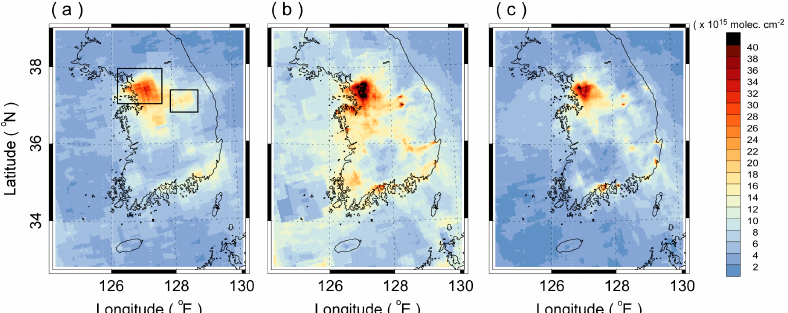
Figure 4. The spatial distributions of tropospheric NO 2 VCD over the South Korean region averaged for a period of January, April, July, and October 2015. ( a ) KNMI OMI NO 2 VCD, ( b ) WRF-Chem modeled NO 2 VCD, and ( c ) WRF / CMAQ modeled NO 2